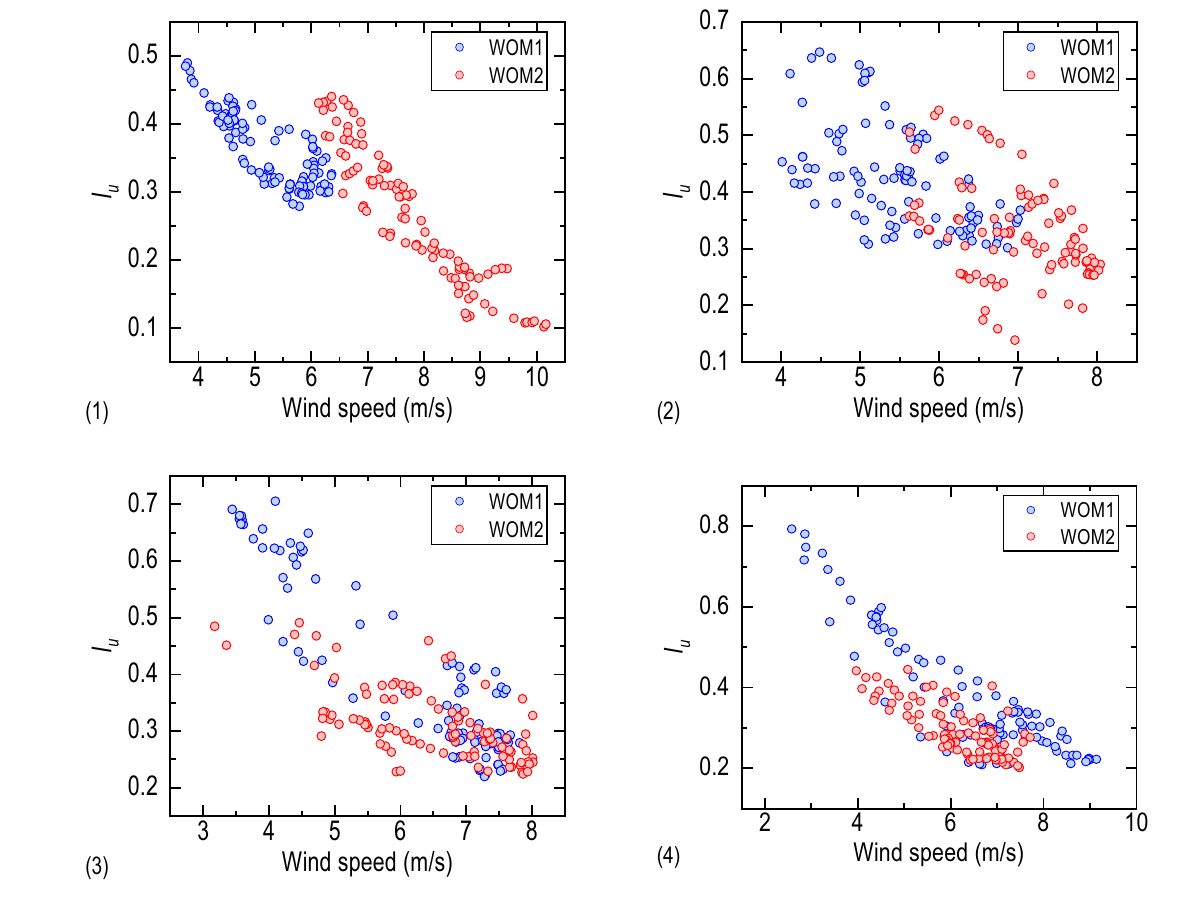
Figure 7. The relationship between turbulence intensity and wind speed at: (1) Lane 1, (2) Lane 2, (3) Lane 3, (4) Lane 4.